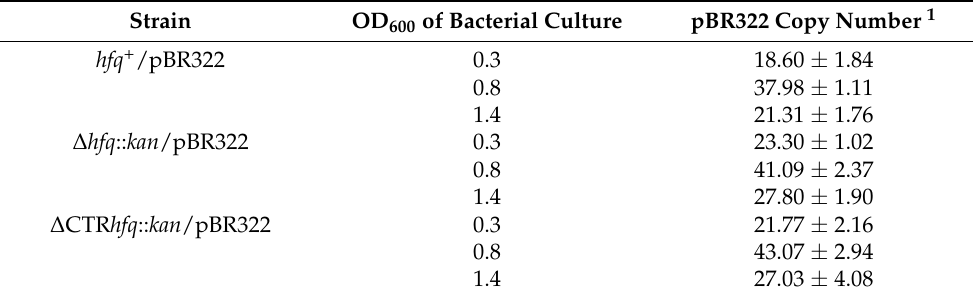
Table 8. Plasmid pBR322 copy number in E. coli hfq + , ∆ hfq :: kan, and ∆ CTR hfq :: kan strains at different phases of bacterial culture